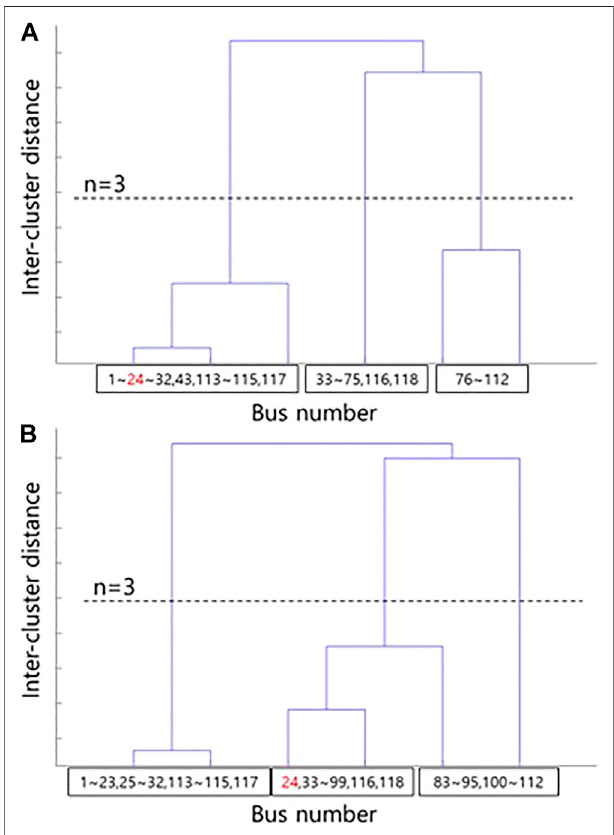
FIGURE 6 | Hierarchical structure at 20% penetration level with respect toPVoutput. (A) Bus24belongstoCluster1. (B)